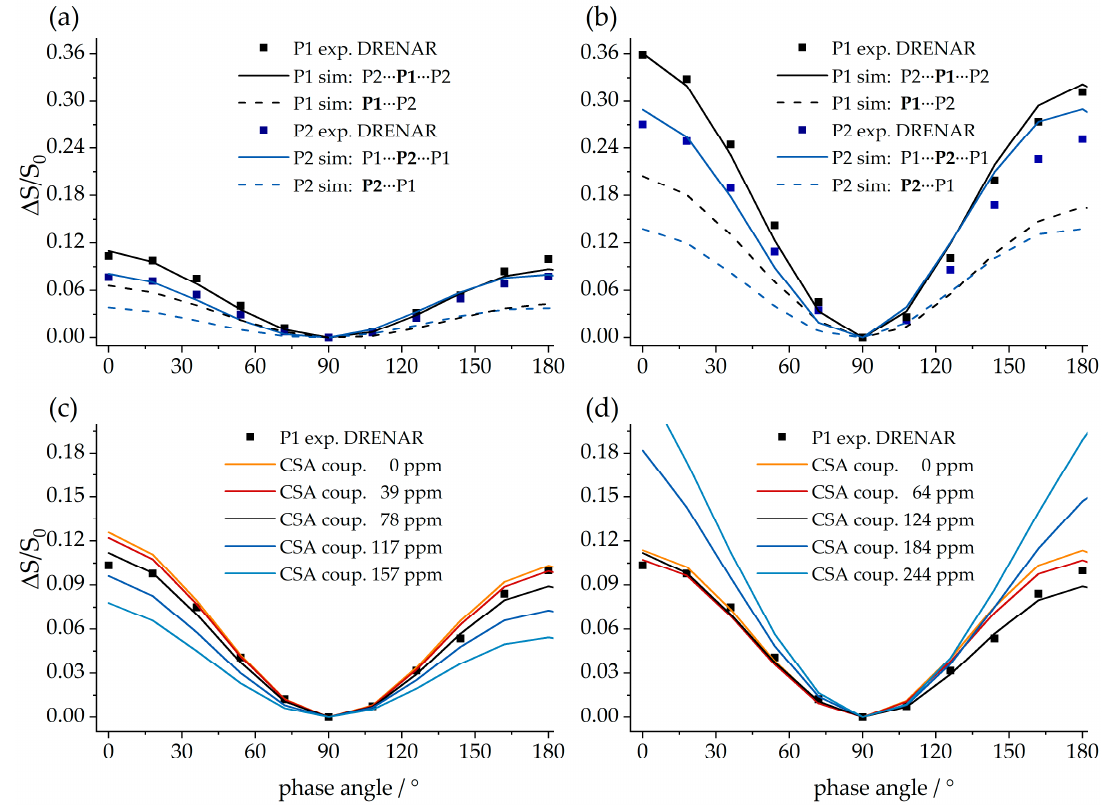
Figure 37. 31 P CT-DRENAR curves for species P1 (black squares) and P2 (blue squares) of the octameric compound 9 acquired using a dipolar mixing time of ( a , c , d ) 1.28 ms and ( b ) 2.56 ms at 7.05 T with a MAS spinning frequency of 12.5 kHz and SWFTPPM 1 H decoupling. In ( a ) and ( b ), simulations for each species based on a two-spin (dashed curves) and a three-spin system (solid curves) are included